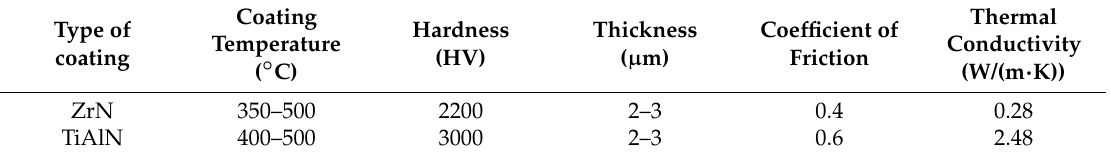
Table 2. Selected mechanical and physical properties of the coatings.